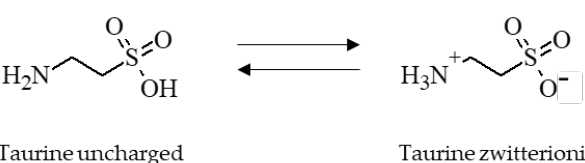
Scheme 1. Chemical structure of taurine showing its two functional groups, the amino group and the sulfonic acid group. Taurine is zwitterionic at an isoelectric point of 5.12 [12]. The molecular weight of taurine is 125.15 g / mol and the molecular formula is C2H7NO3S [13]. Excitatory tissues such as the retina, brain, heart and skeletal muscle [12,14,15] contain especially